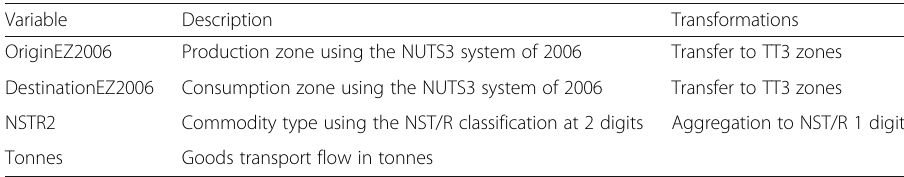
Table 4 Data structure of trade matrices Variable